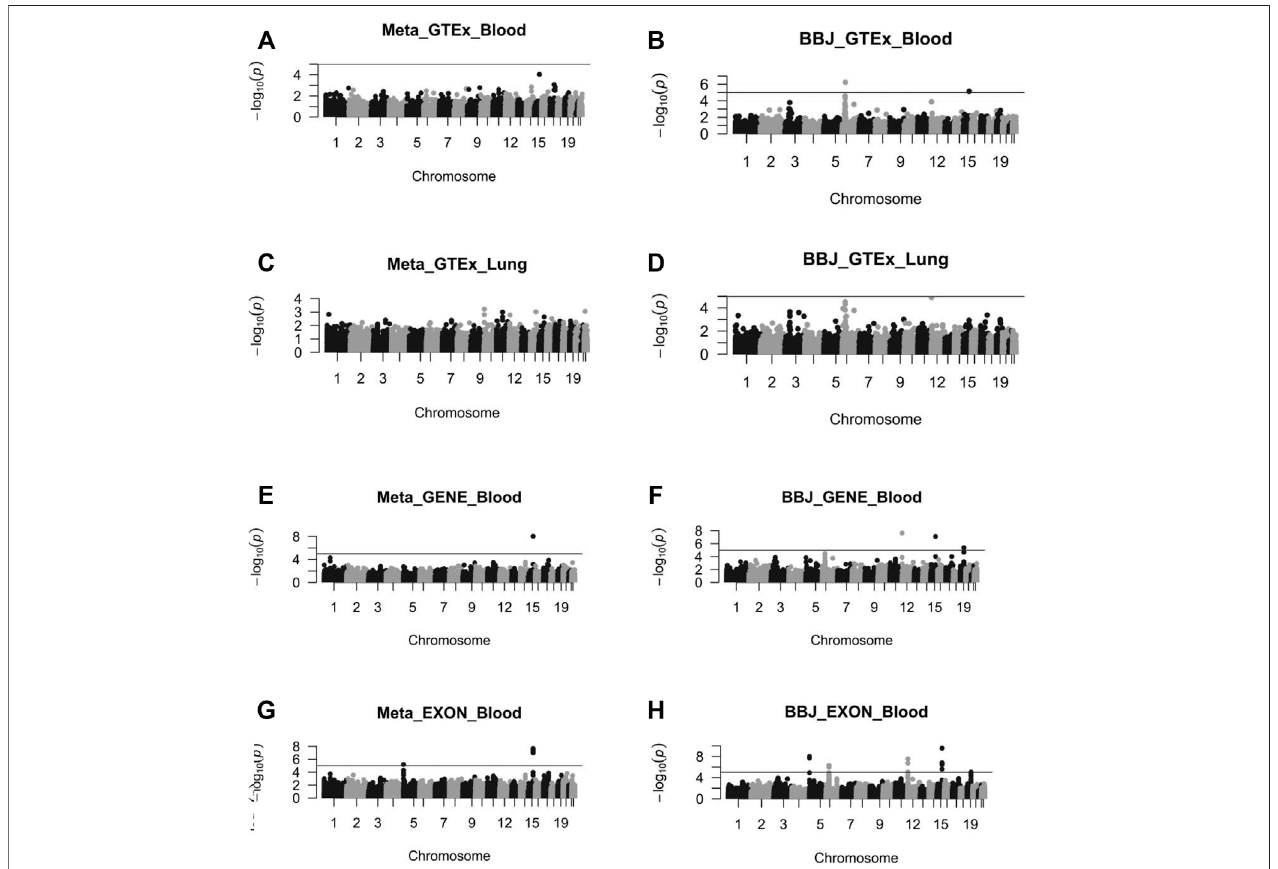
FIGURE 4 | The Manhattan diagram of these eight SMR analysis results. (A) the SMR analysis results of Meta_GTEx_Blood. (B) the SMR analysis results of BBJ_GTEx_Blood. (C) the SMR analysis results of Meta_GTEx_Lung. (D) the SMR analysis results of BBJ_GTEx_Lung. (E) the SMR analysis results of